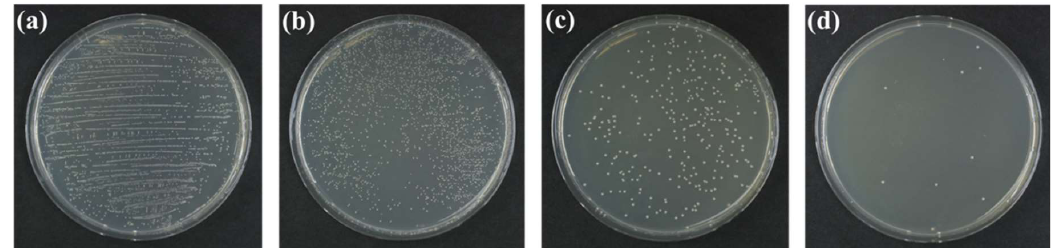
Figure 3. Results of disinfection for S. warneri ; ( a ) control, ( b ) disinfecting by DUV light (57 µ W/cm 2 ), ( c ) disinfecting by running water (400 mL/min), and ( d ) disinfecting by the water-waveguide method (143 µ W/cm 2 and 400 mL/min); the durations of treatments ( b – d ) were 1 min. The number of colonies counted were ( a ) 18,300 ± 4831 colony forming unit (CFU) for the control plate, reduced to ( b ) 3510 ± 1588 CFU by 1 min of DUV disinfection treatment, ( c ) 201 ± 141 CFU by 1 min of the disinfection with running water, and ( d ) 9.3 ± 5.2 CFU by 1 min of water-waveguide treatment. Here, the numbers of CFU are reported as the means and standard deviations of at least three independent experiments. For counting the number of CFU of original ( a , b ) plates, dilutions (10 − 2 –10 − 1 ) of the suspensions for ( a , b ) were prepared. Significant differences were observed between ( c , d ), and the probability value (P) was found to be P = 0.034.